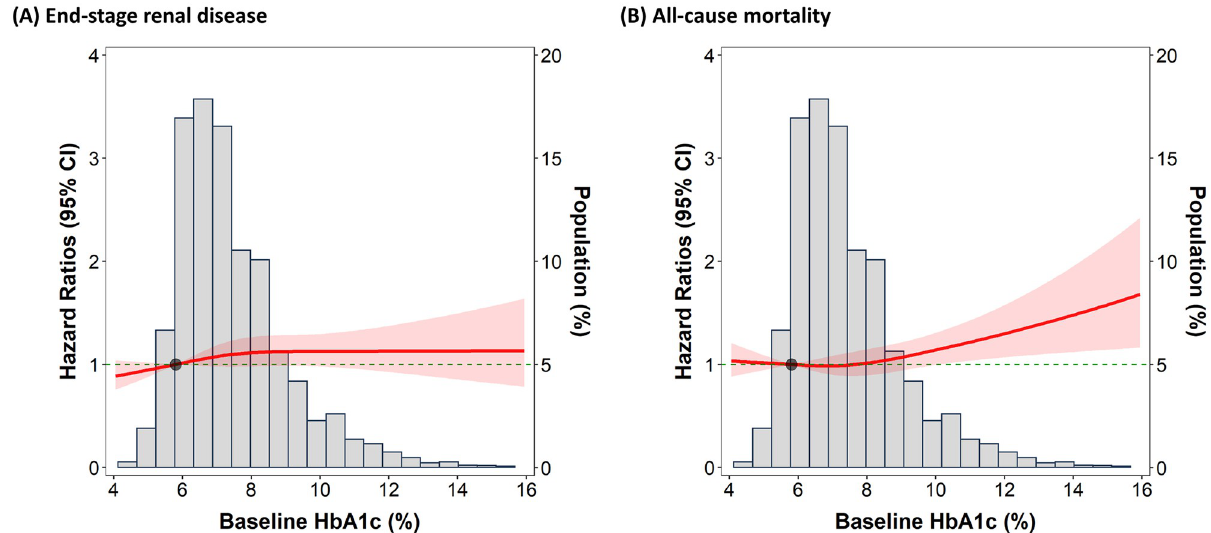
Fig 3. Dose-response plot of the baseline HbA1c and adjusted hazard ratios for (A) progression to end-stage kidney disease and (B) all-cause mortality according to baseline HbA 1c (%). Solid lines represent adjusted hazard ratios based on restricted cubic splines for baseline HbA 1c , with knots at the 10th, 50th, and 90th percentiles. Shaded areas represent the upper and lower 95% confidence intervals. The reference was set at the 10th percentile of HbA 1c levels. Variables adjusted are the same as that shown in Model 3 presented in Table 2. Missing values were imputed by multiple imputation.